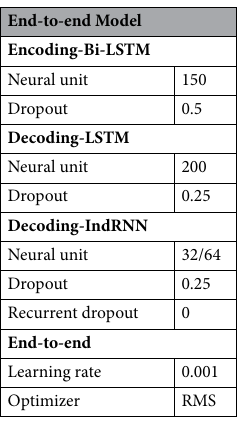
Table 1. Parameter settings.